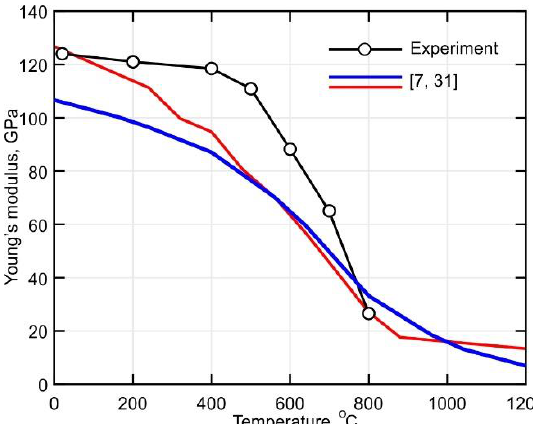
Figure 12. Comparison of the measured Young’s modulus of the Ti-6Al-4V alloy with published data from [7,31].